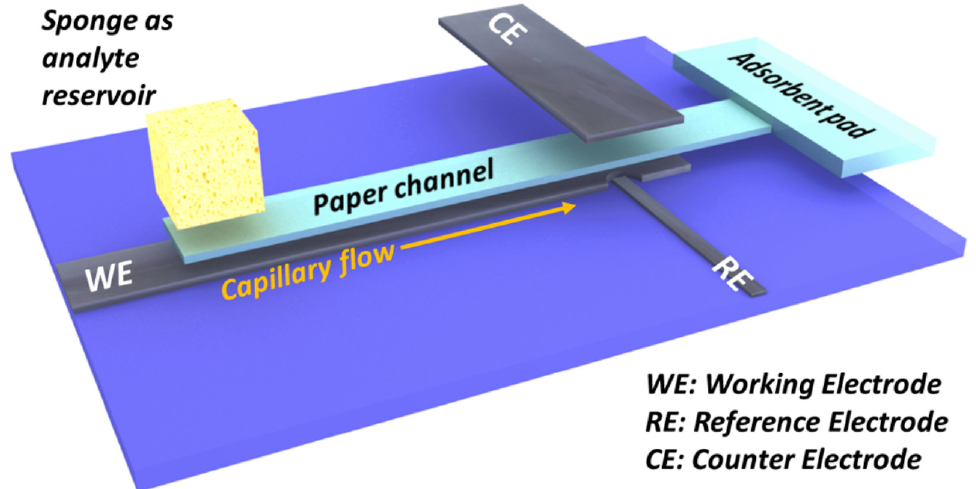
Figure 6. Diagram of the microfluidic detection device developed on paper (blue) and graphite foil (black) by Shen et al. [157]. Figure reproduced with permission from American Chemistry Society.